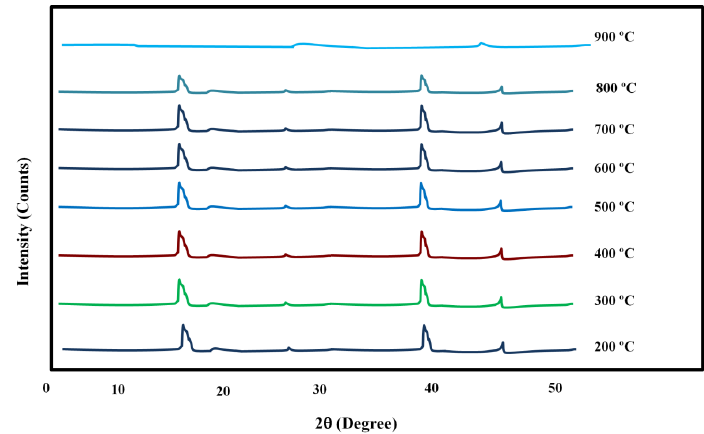
Figure 1. X-ray diffraction (XRD) patterns of natural clinoptilolite samples treated at 200 °C; 300 °C; 400 °C; 500 °C; 600 °C; 700 °C; 800 °C, and 900 °C for 1 h.